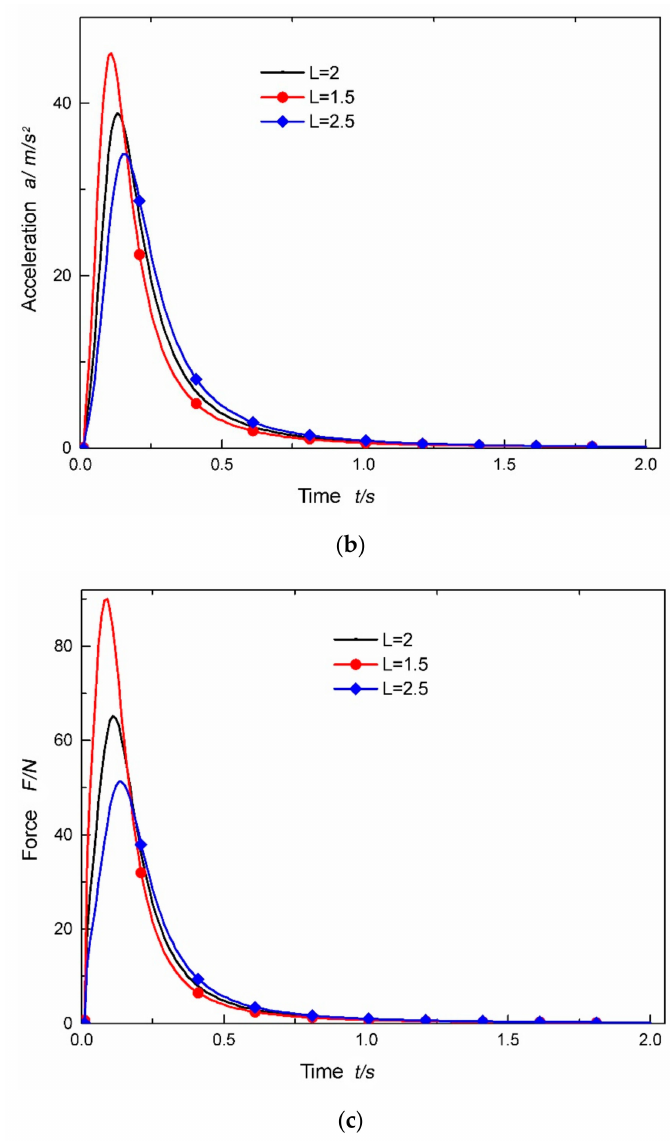
Figure 17. Influence of arresting rod width on arresting process. ( a ) The change of UAV velocity, v ; ( b ) the change of UAV acceleration, a ; ( c ) the change of internal force, F c of the arresting cable. The impact of UAV mass m changes on the recovery process is shown in Figure 18. From the abovementioned data, it can be concluded that, when the mass, m , of the UAV is